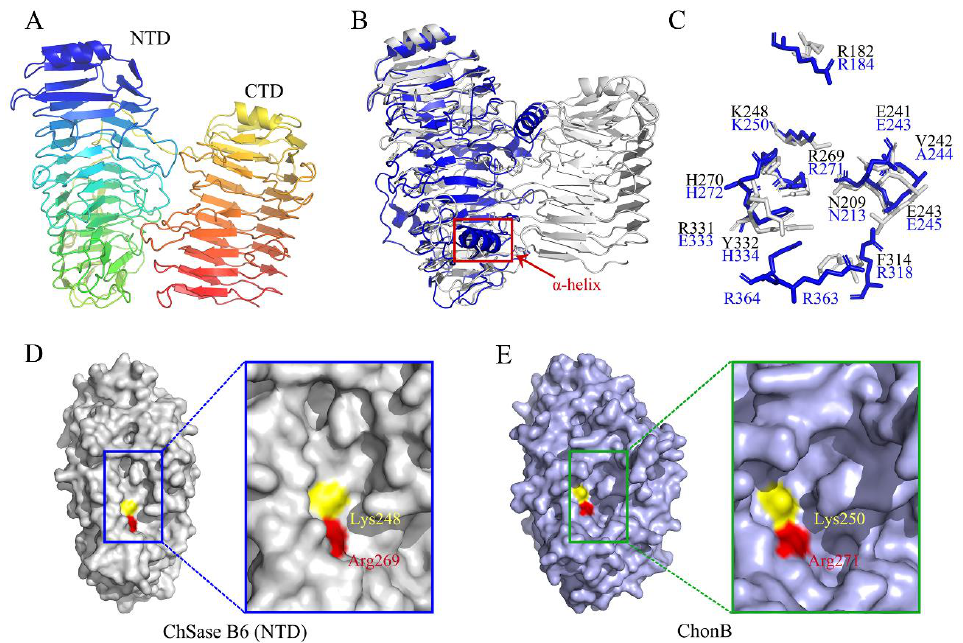
Figure 6. Structural comparison of ChSase B6 and ChonB. ( A ) Overall structural of ChSase B6. ( B ) Structural alignment of ChSase B6 and ChonB. ChSase B6 is colored in gray. ChonB is shown in blue schematic view and the α -helix is circled. ( C ) Partial superposition of ChSase B6 and ChonB. Residues of ChSase B6 and ChonB are shown in gray and blue, respectively. ( D ) Surface views of the NTD of ChSase B6. ( E ) Surface views of ChonB. The catalytic clefts are circled. Brønsted bases and acids are colored in yellow and red,